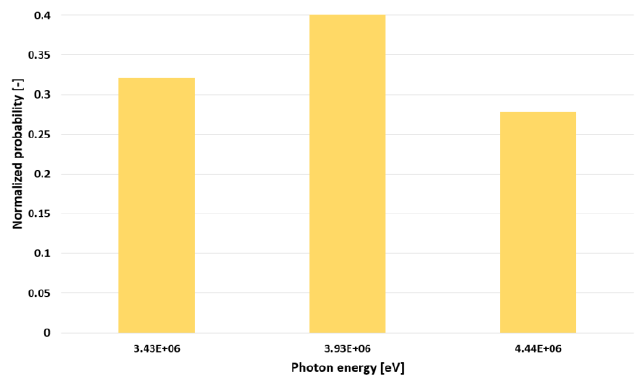
Fig. 3. PuBe photon emission spectrum